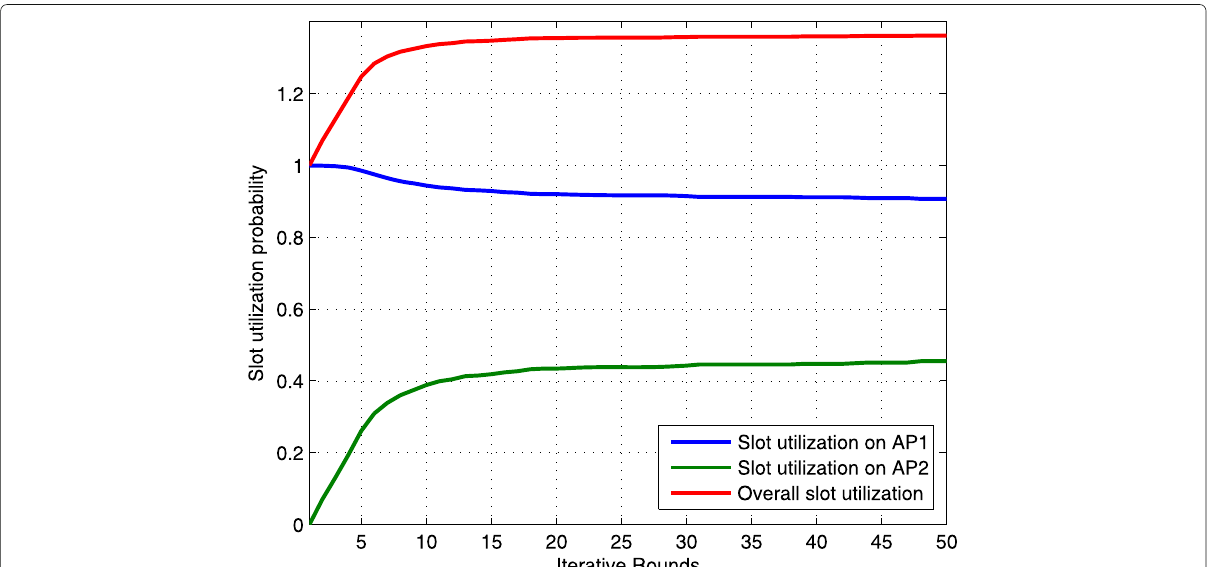
Fig. 7 The slot utilization of APs in 50 rounds. The figure shows the slot utilization of each AP and the total slot utilization of the existing two APs